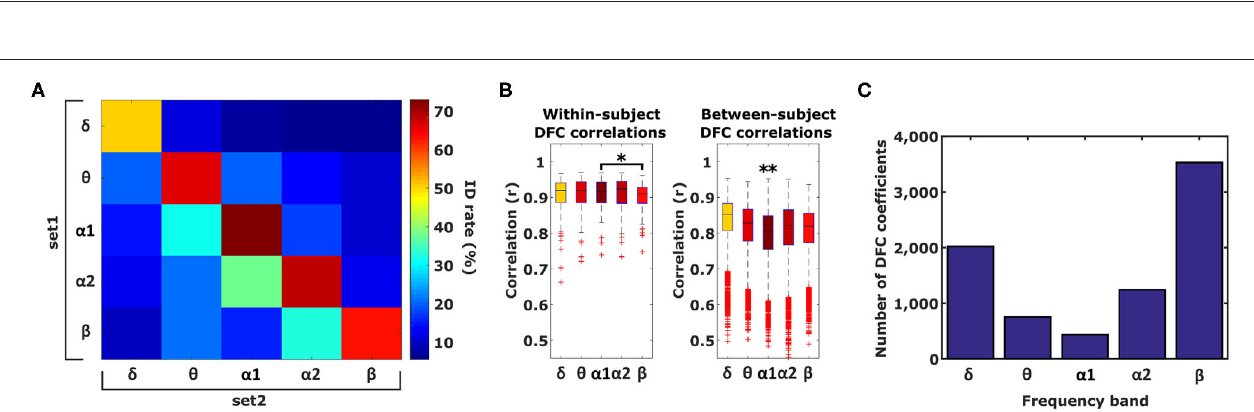
FIGURE 2 | DFC calculation. (A) Example of 10 functional connectivity (PLI) time-series calculated for 30 s of EEG using 250 ms long epochs in the θ frequency band. PLI values range between 0 and 1 and for visualization purposes PLI time-series are stacked on top of each other. (B) Corresponding 10 by 10 symmetric correlation matrix of the 10 functional connectivity time-series. Each position indicates the Pearson’s correlation coefficient between two PLI time-series, called a dynamic functional connectivity (DFC) coefficient. L, left hemisphere; FP, fronto-polar; FM, frontal-mid; FL, frontal lateral; CM, central mid; CL, central lateral; TA, temporal anterior; TP, temporal posterior; PL, parietal lateral; PM, parietal mid; PO, parietal occipital; OC, occipital.